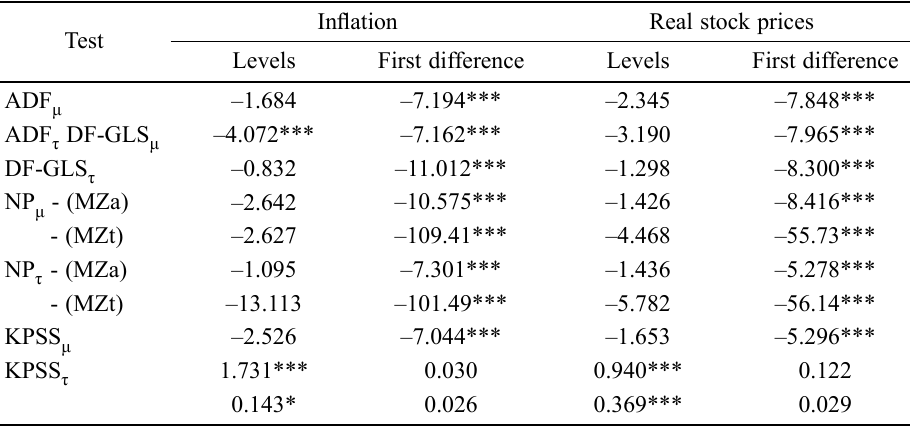
Table 1. Unit root test